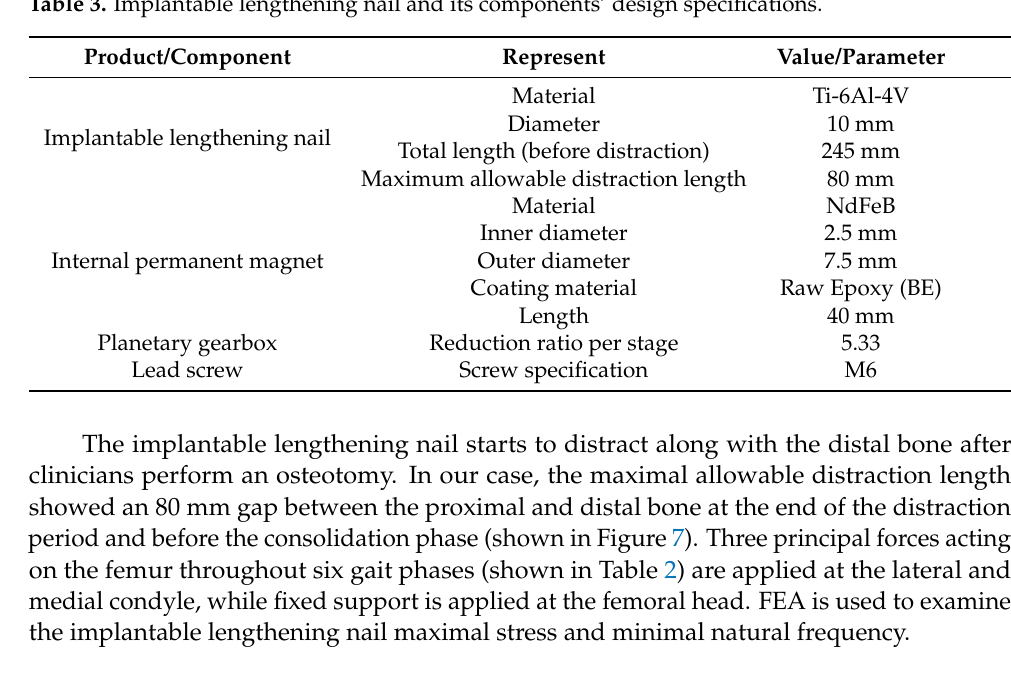
Table 3. Implantable lengthening nail and its components’ design specifications.